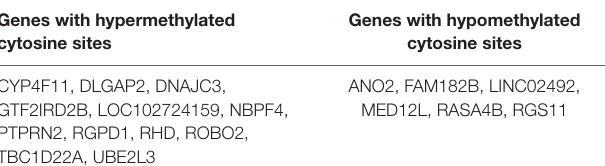
Genes with hypomethylated cytosine